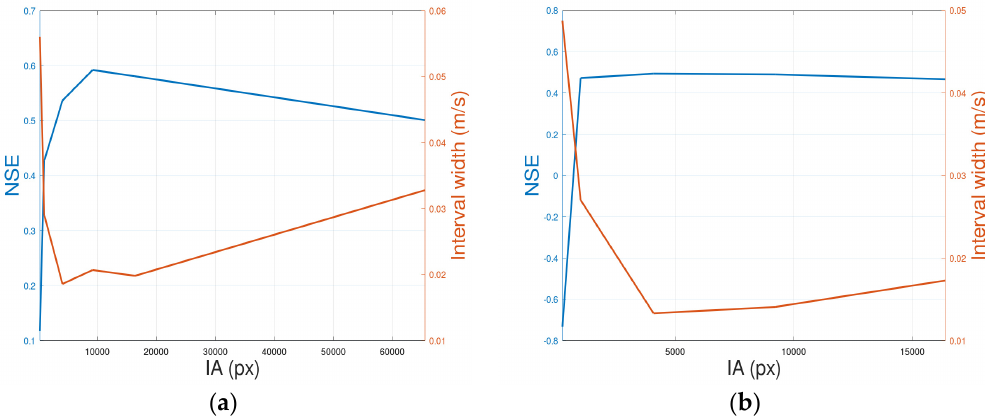
Figure 5. The impact of the mean IA size ( L × L ) on the accuracy of the estimated velocities and the 90% confidence interval width for Video A and the cross-sections S1 ( a ) and S2 ( b ).